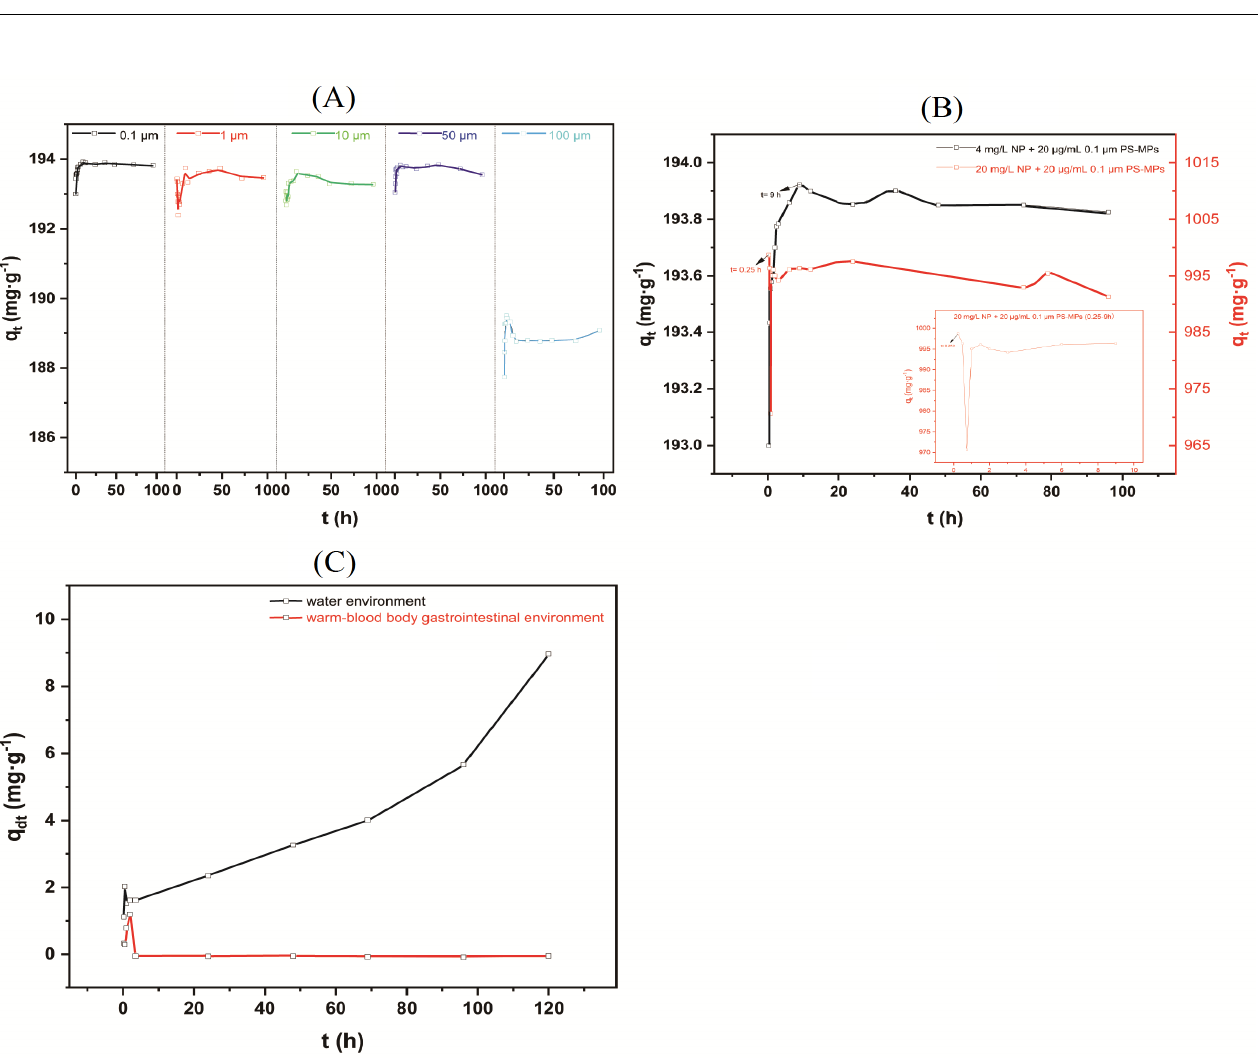
Figure 2. Effects of reaction time on the adsorption and desorption of NP in PS − MPs. ( A ) Adsorption process of NP solutions (4 mg/L) with 20 µ g/mL PS − MPs with different particle size (0.1, 1, 10, 50, and 100 µ m). ( B ) Effect of different initial NP concentrations (4 and 20 mg/L) on time-sorption capacity trends. ( C ) The desorption behavior of NP on the PS − MPs in the water environment (pH 7.0, 3.5% sodium chloride, 25 ± 2 ◦ C and 150 r/min) and the warm-blood body gastrointestinal environment (pH = 2.8, 15.5 mmol/L sodium taurocholate, 10 g/L of pepsin, 35 ± 2 ◦ C and 100 r/min) was